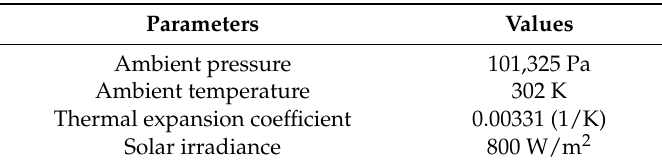
Table 2. Main input parameters of the